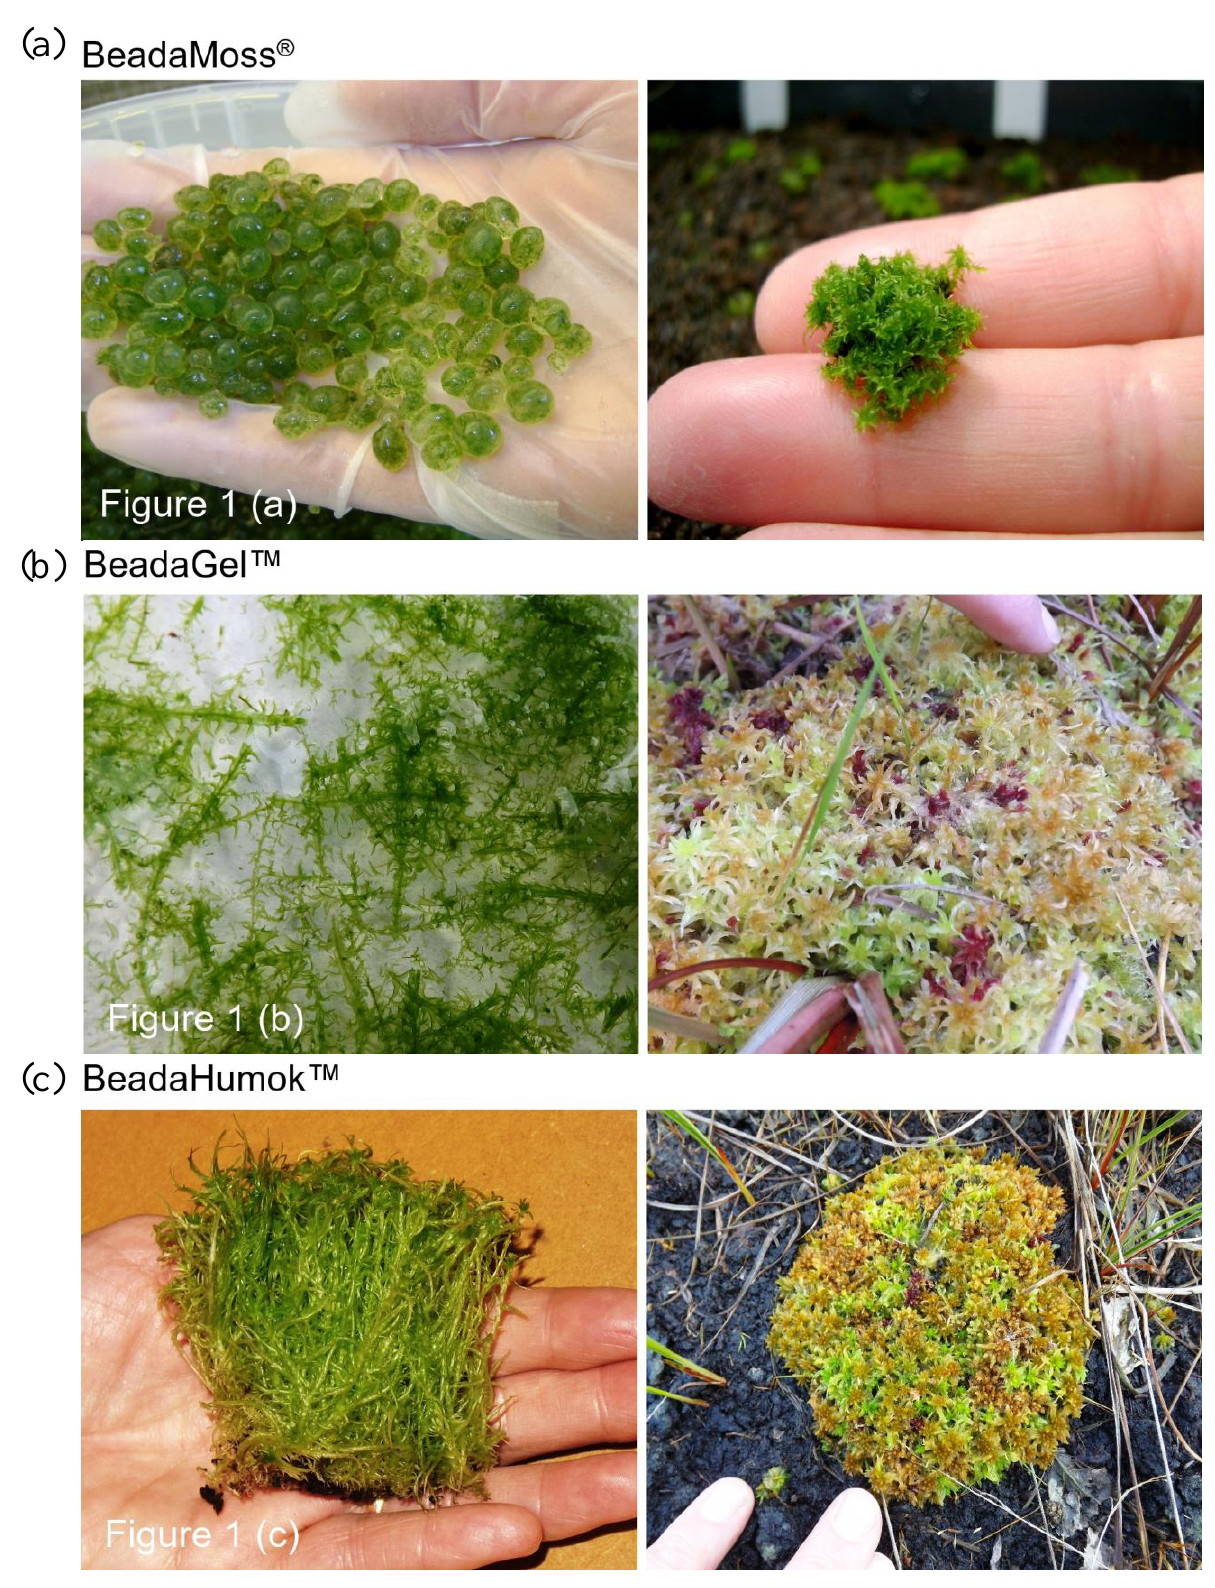
Figure 1. Micropropagated Sphagnum moss. (a) Sphagnum beads (BeadaMoss ® ), right-hand picture shows BeadaMoss ® Sphagnum growth six weeks after planting in a glasshouse. (b) Sphagnum gel (BeadaGel™), right-hand picture shows BeadaGel™ 15 months after planting in the field (Cadishead, Manchester). (c) Sphagnum (BeadaHumok™), right-hand picture shows BeadaHumok™ 15 months after planting in the field (Cadishead,